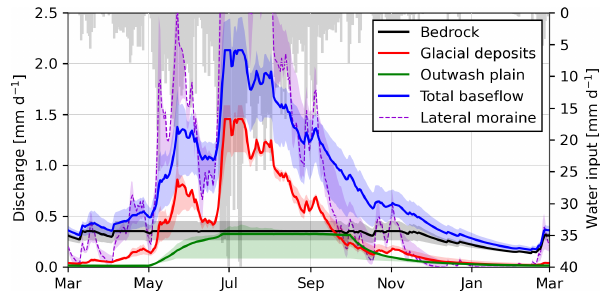
Figure 12. Evolution of modeled groundwater baseflow discharge of different hydrogeomorphological landforms. Total baseflow rep- resents the sum of the outwash plain, flat glacial deposits, and bedrock discharge; steep lateral moraines are also plotted but are not considered in the sum of baseflow due to their fast response. Simulated total water input (snowmelt and rain) is plotted in